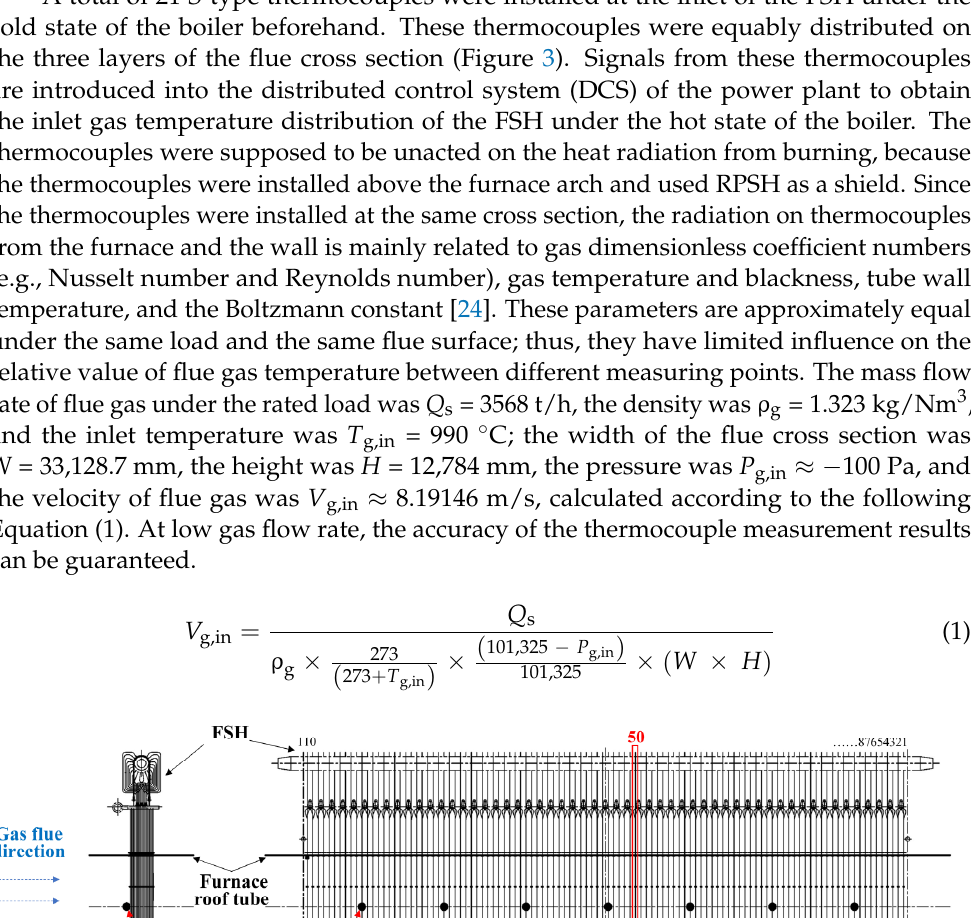
Figure 2. The metal material, pipe specifications, and allowable temperatures of the FSH.